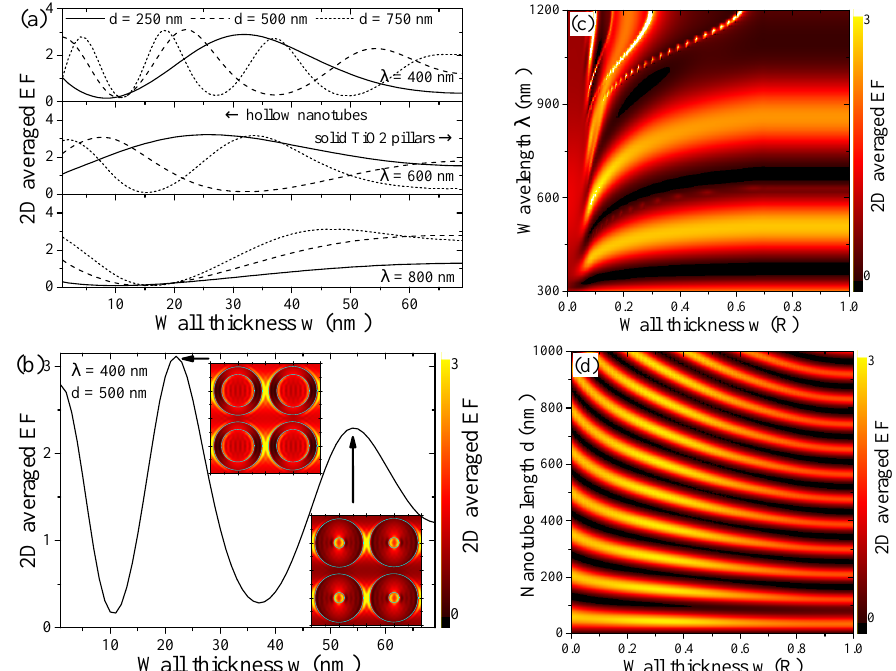
Figure 5. As a function of the wall thickness w , the averaged field enhancement | (cid:126) E av,2D | 2 / | (cid:126) E ref | 2 is presented for ( a ) several NT lengths d and excitation wavelengths λ with a detailed look at a specific configuration in ( b ), adding the field maps for two of the maxima; ( c ) Similar to Figure 3b, we show its full spectral dependence as a contour; ( d ) The full contour as a function of the NT length d , showing the maxima of Figure 4a shifting in a nonlinear manner with decreasing wall thickness w